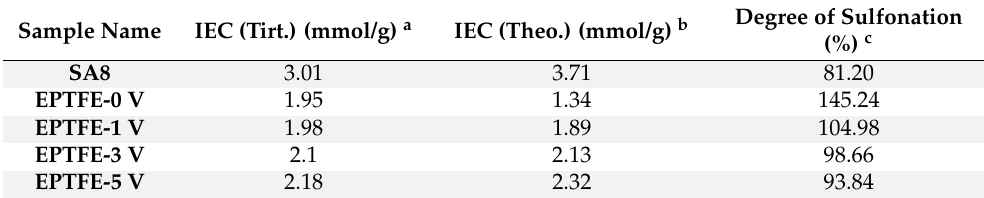
Table 1. IEC values of SA8 and ePTFE membranes.